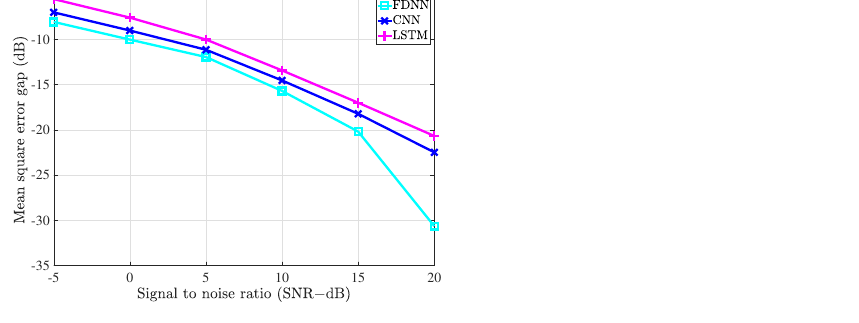
Figure 11. The MSE gap (dB) between the deep learning-based channel estimation methods and the LMMSE estimation with f D = 36 Hz.